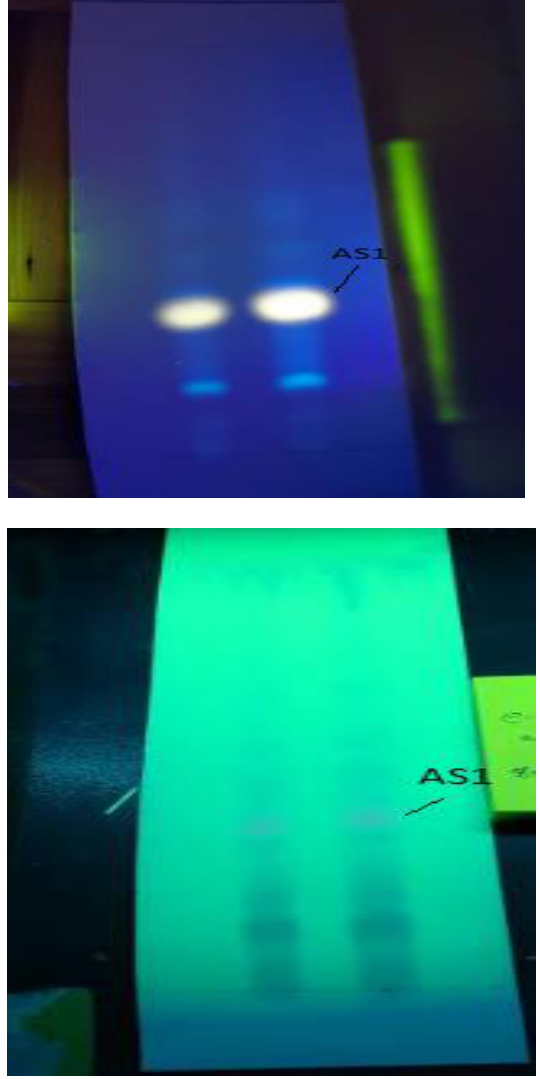
Figure 4. TLC of n-butanol fraction before hydrolysis with different titration under UV 253nm and